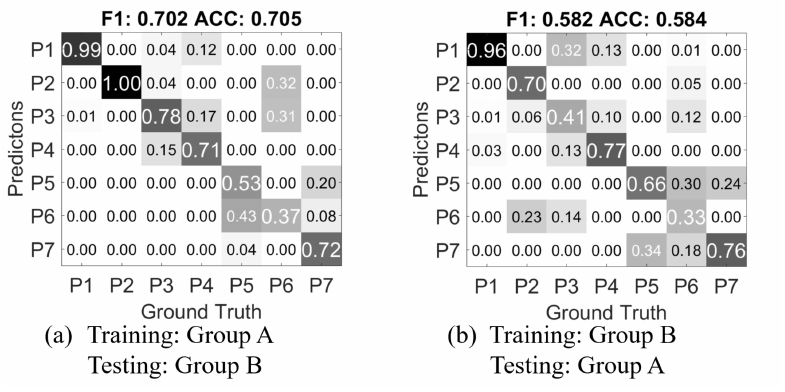
Figure 11. Confusion matrix of the validations using Group A and Group B as training and